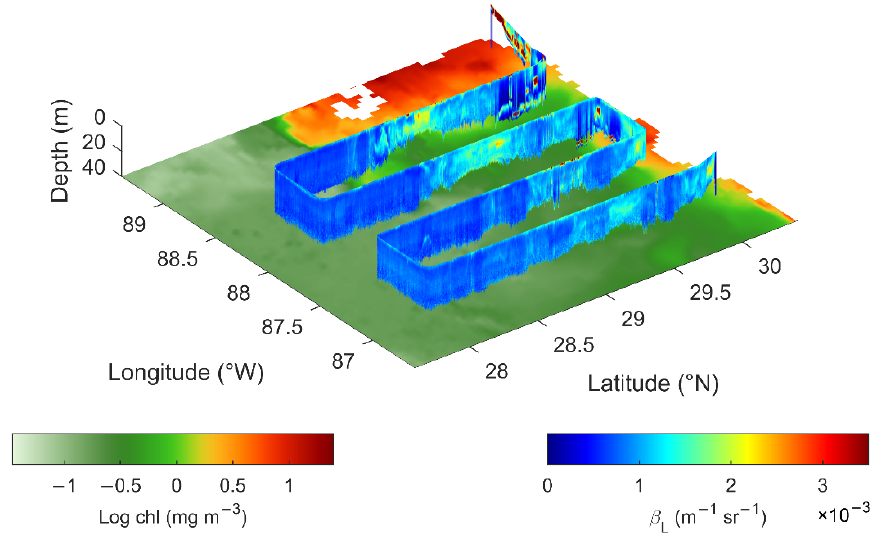
Figure 3. The three-dimensional distribution of the backscattering coefficient of the detection route on 24 September 2011. The base map shows the chlorophyll concentration at the sea surface.